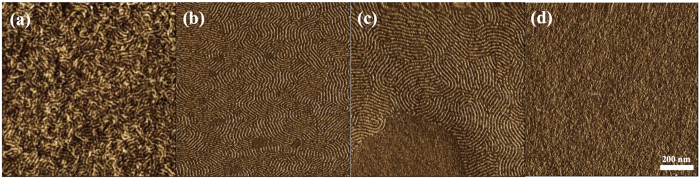
AFM phase images of a 32-nm-thick (=2.0L0) PS100-b-PMHxOHS25 film(a) before annealing, (b) after annealing at 130 °C for 1 min, (c) after annealing at 140 °C for 1 min, and (d) after annealing at 150 °C for 1 min with a PMMA-r-PMA film.